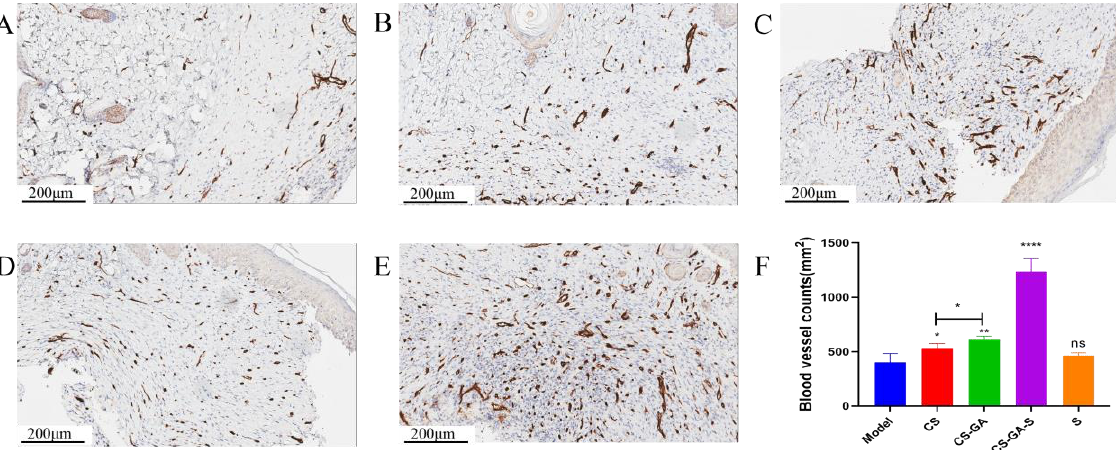
Figure 12. Representative IHC images of regenerated wound tissues with anti-CD31. ( A ) Model group, ( B ) CS group, ( C ) hydrogel group, ( D ) scolopin2 group, and ( E ) CS-GA-S group. ( F ) The blood vessel counts. Scale bar: 200 µ m. ns represents no significance, * represents p < 0.05, ** represents p < 0.005, **** represents p < 0.0001.